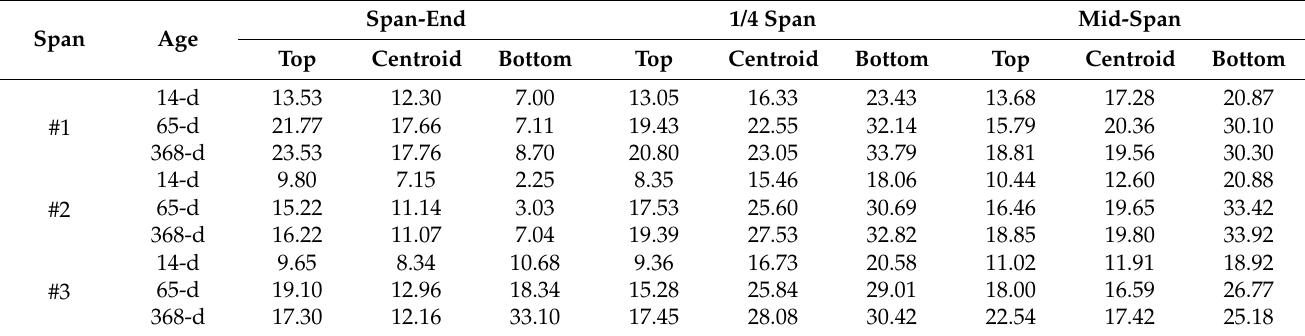
Table 4. Stress values based on the linear simplified